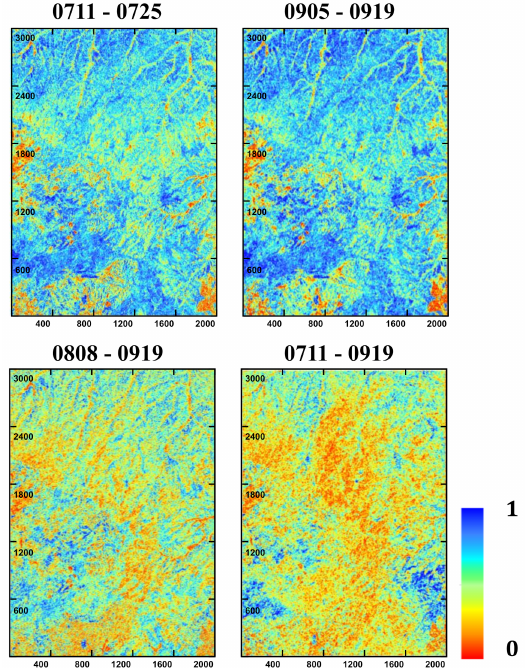
Figure 16. Coherence images for different interferometric data; 0711-0725 and 0905-0919 data sets have higher coherence, 0808-0919 data set has lower coherence, and 0711-0919 data set has the lowest coherence. The data with larger temporal baselines have lower coherence, and temporal decorrelation decreases the coherence. The spatial distribution of coherence is not uniform and receives a combination of volume decorrelation and temporal